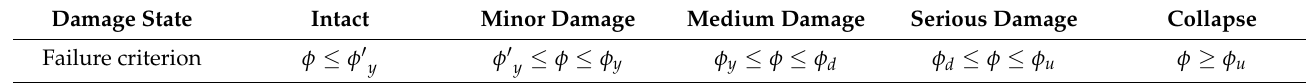
Table 2. Damage status and description of damage index for piers.